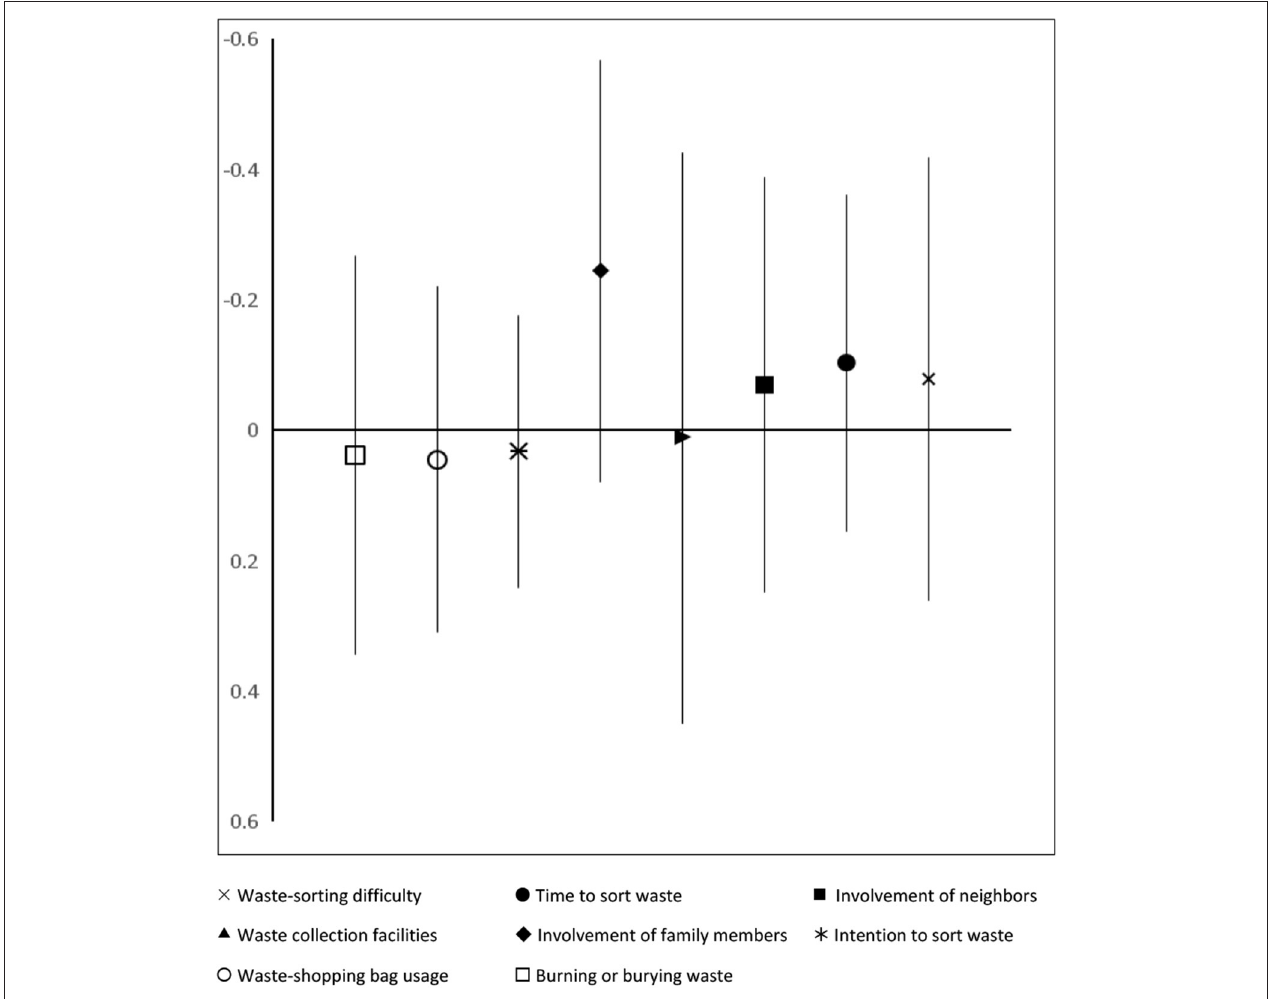
FIGURE 2 | Effects of past volunteering in clean-up on pro-environmental knowledge, intention, and practices. × , Waste-sorting difficulty; • , Time to sort waste; (cid:4) , Involvement of neighbors; N , Waste collection facilities; (cid:4) , Involvement of family members; *, Intention to sort waste; ◦ , Waste-shopping bag usage; (cid:3) , Burning or burying waste. The plot shows the statistically insignificant effects of volunteering in clean-up activities on environmental knowledge and pro-environmental practices. Full regression results are reported in Supplementary Table 6